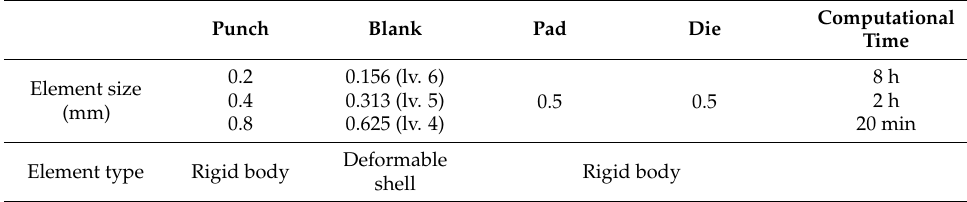
Table 6. The anisotropic parameters of the Hill’s 1948 yield criteria used in the simulation.